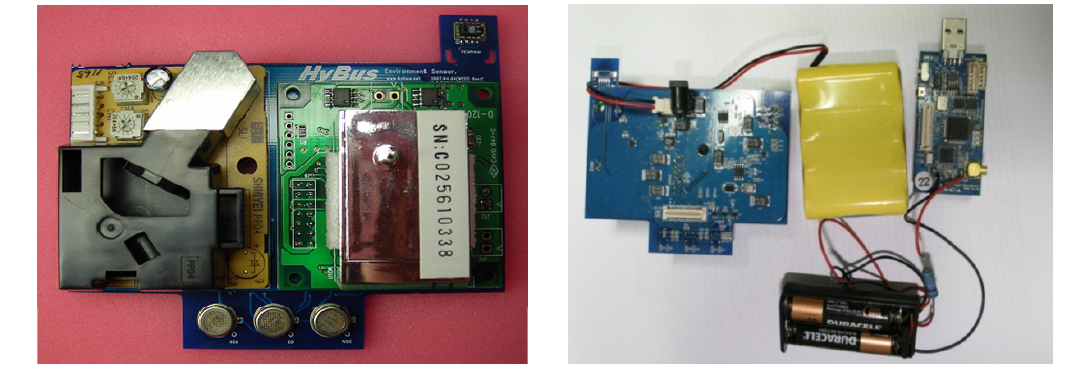
Figure 1. Add-on sensor board and dual power